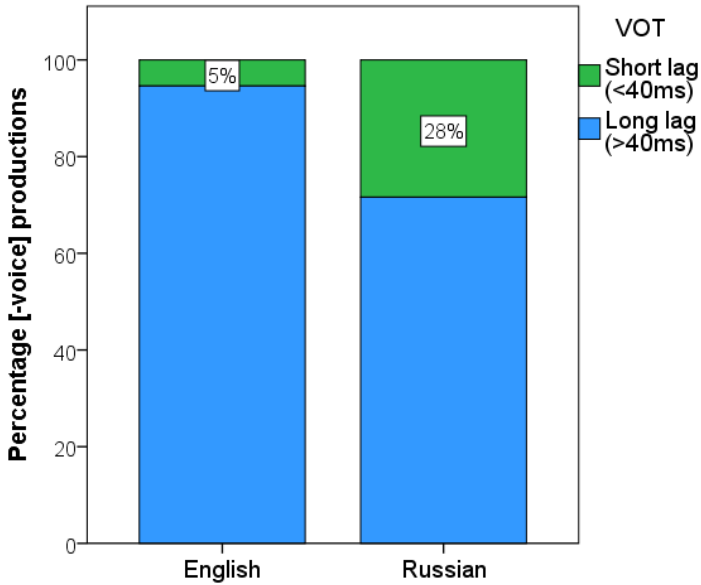
Figure 1. Mean positive voice onset time (VOT) of voiced and voiceless initial stops in learners’ English and Russian.